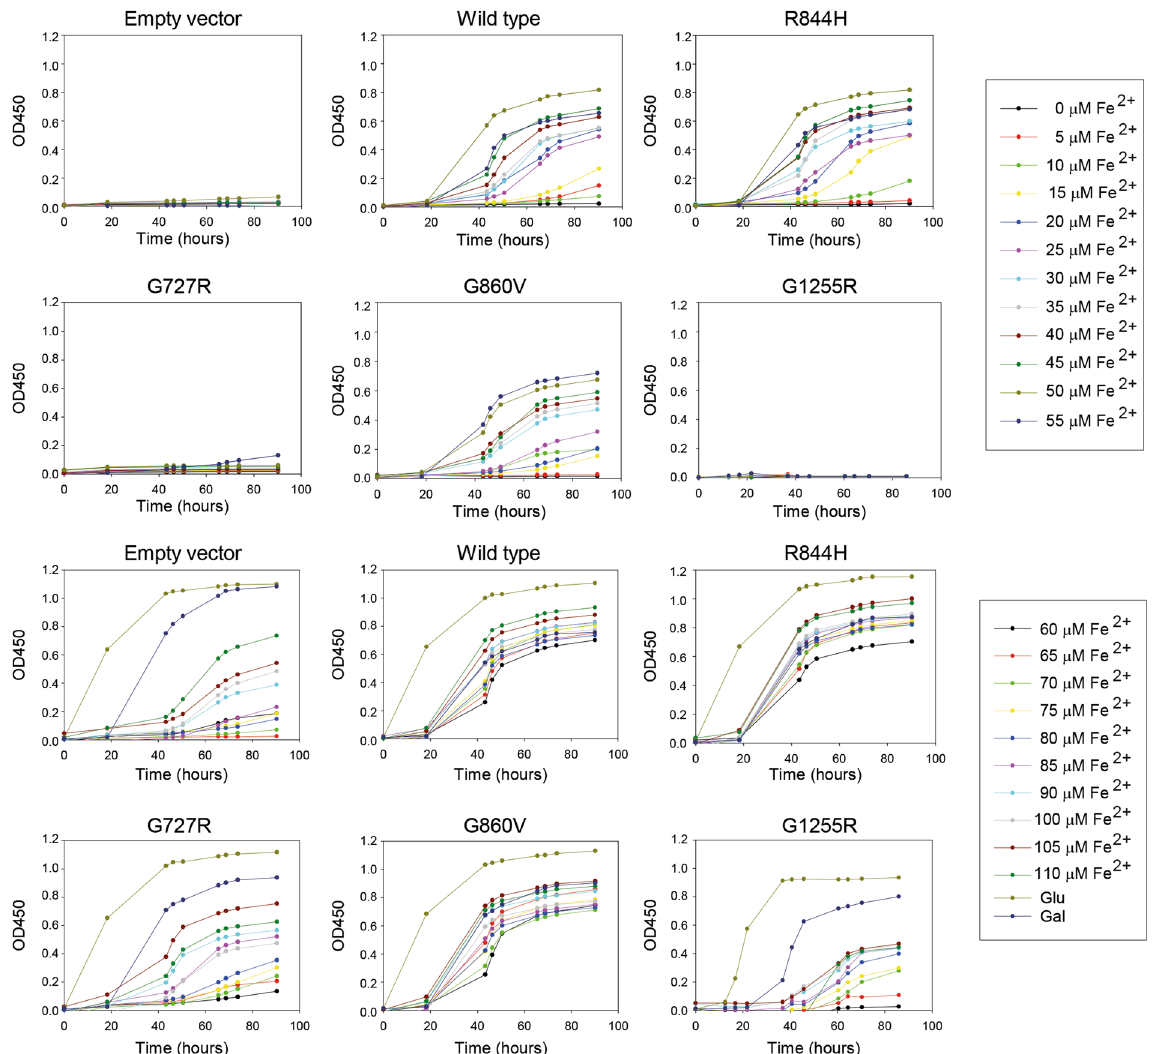
Figure 9. Complementation of the ccc2 Δ iron requiring phenotype in liquid culture. The mutants R844H, G860V and G1255R leading to no, or only little protein accumulation in patient fibroblasts and the frequent mutant G727R were investigated for their ability to complement the high iron requirement of a ccc2 Δ yeast strain in liquid cultures containing 1 mM Ferrozine and increasing amounts of Fe 2 + , as indicated. Wild-type, ccc2 Δ yeast cells producing wild-type ATP7A; Empty vector, ccc2 Δ yeast cells expressing no